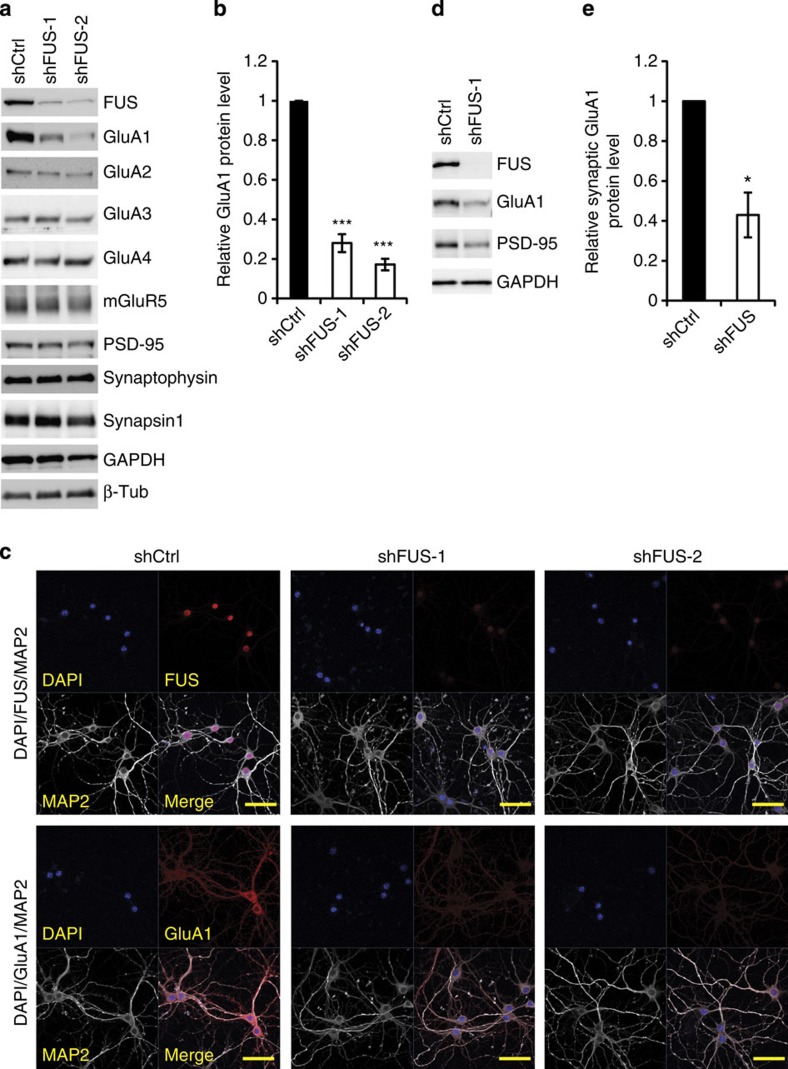
FUS depletion downregulates GluA1 protein level in cultured neurons.(a) Mouse cultured cortical neurons were infected by lentiviruses expressing scrambled shRNA (shCtrl) or shRNA for FUS (shFUS-1 and shFUS-2) at DIV 10. Ten days post infection, the lysates were prepared and protein levels were analysed by western blot using the antibodies indicated. (b) Quantification of GluA1 protein levels in a (n=4; F(2, 9)=298.4, P<0.0001, one-way analysis of variance; ***P<0.001, Tukey's test post hoc). (c) Primary hippocampal neurons were transduced as in a and immunostained for MAP2 and FUS or GluA1 together with 4,6-diamidino-2-phenylindole (DAPI) staining. Scale bar, 50 μm. (d) Synaptoneurosomes were prepared from the control (shCtrl) and FUS knockdown (shFUS-1) primary cortical neurons and western blotted with the indicated antibodies. (e) Quantification of synaptic GluA1 protein levels in d (n=3, t=5.063 **P=0.037, paired t-test).